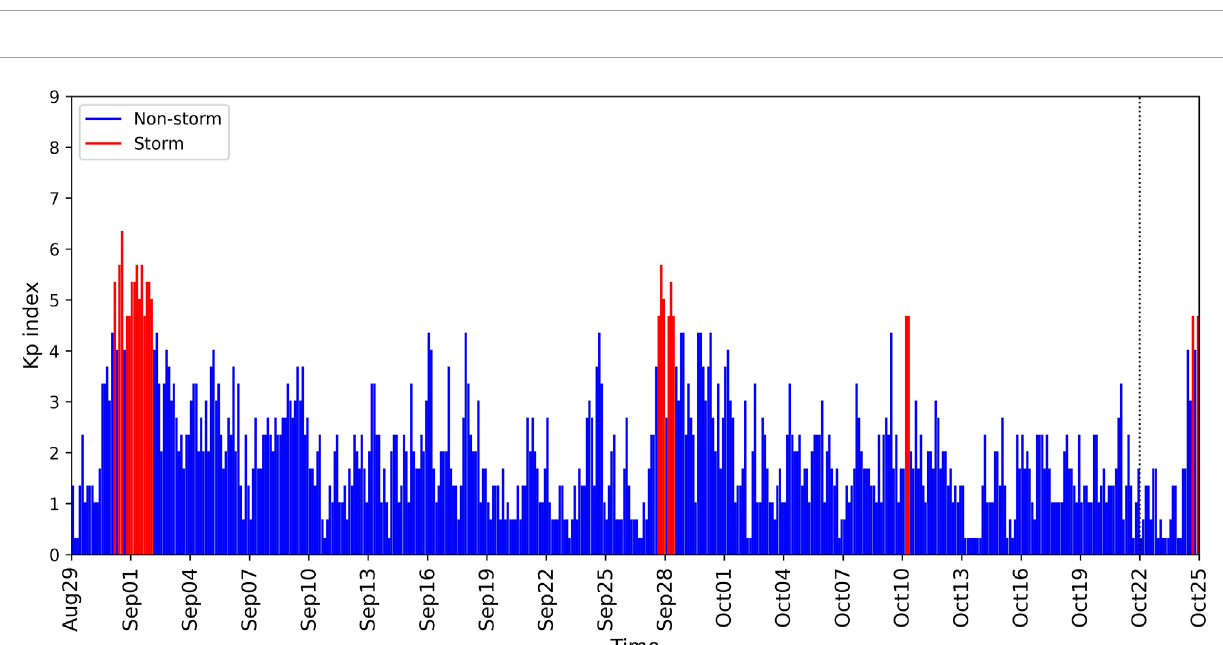
FIGURE 2 Illustration of preparing the 3-h Kp index time series for the current T at 00:00 UTC on 22 Oct 2019. The 3-h Kp index is represented by a blue (red) bar if it is related to the non-storm (geomagnetic storm) period. The black vertical line refers to the current time point T. The left side of the line refers to the previous 54-day Kp index time series (one of the model inputs). The right side of the line refers to the next 3-day Kp index time series (the model